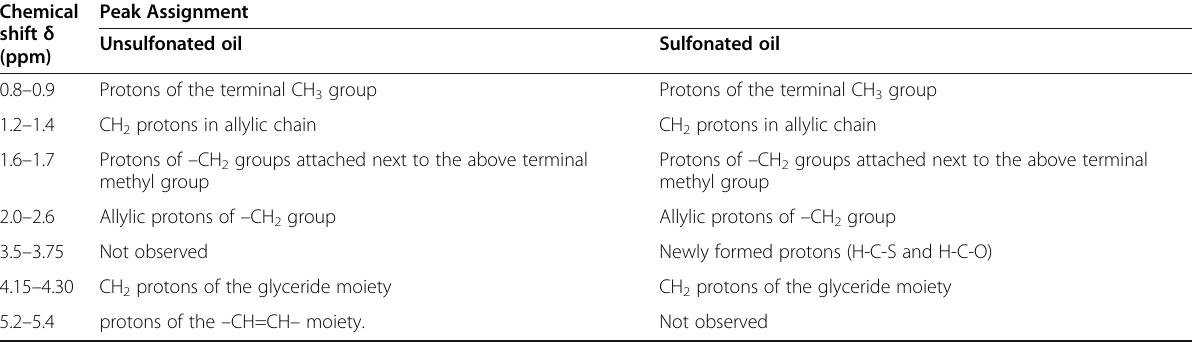
Table 5 1 H NMR evaluation of unsulfonated and sulfonated oils Chemical shift δ